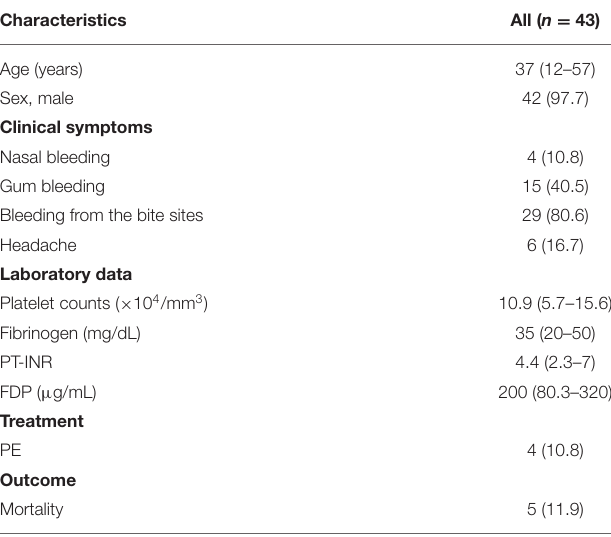
TABLE 1 | Population characteristics of the patients.